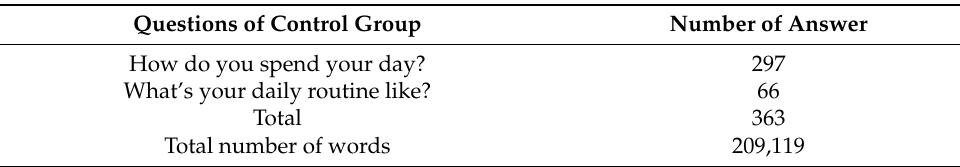
Table A2. Text information of control